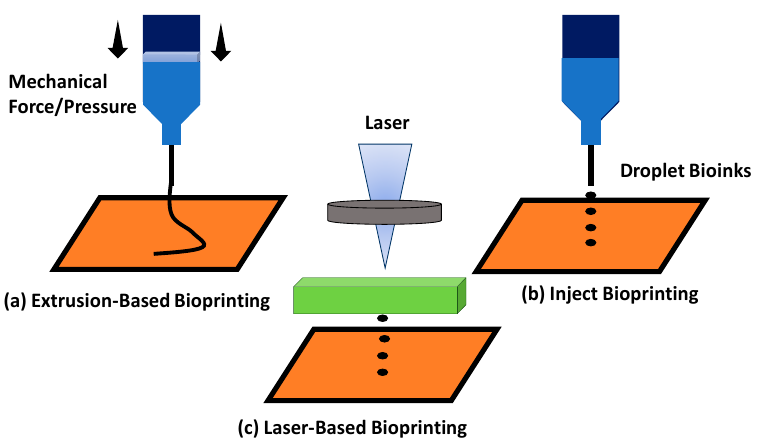
Figure 4. Different types of printing techniques: ( a ) extrusion-based bioprinting; ( b ) inject bioprinting; and ( c ) laser-based bioprinting.